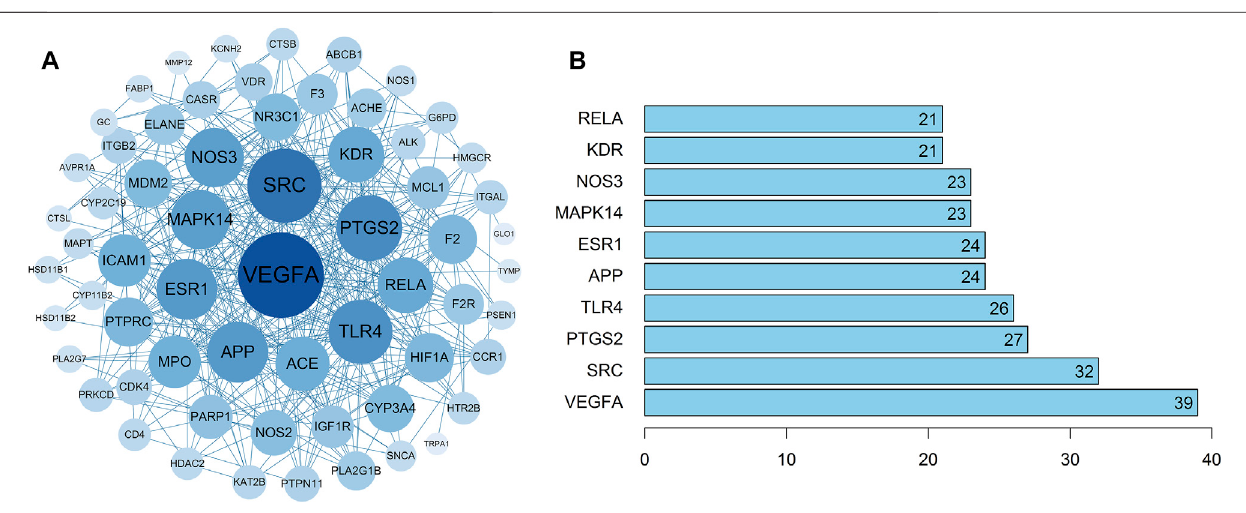
Frontiers in Pharmacology |